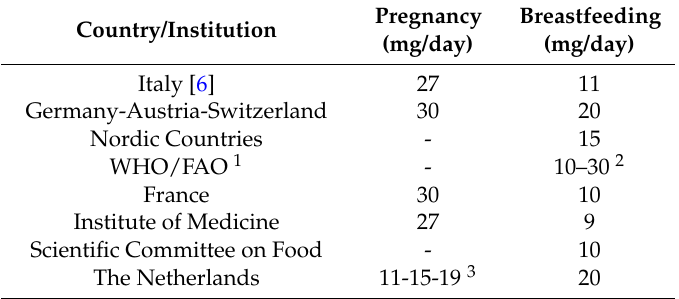
Table 2. Different recommended intakes for iron in pregnancy and breastfeeding. Modified from